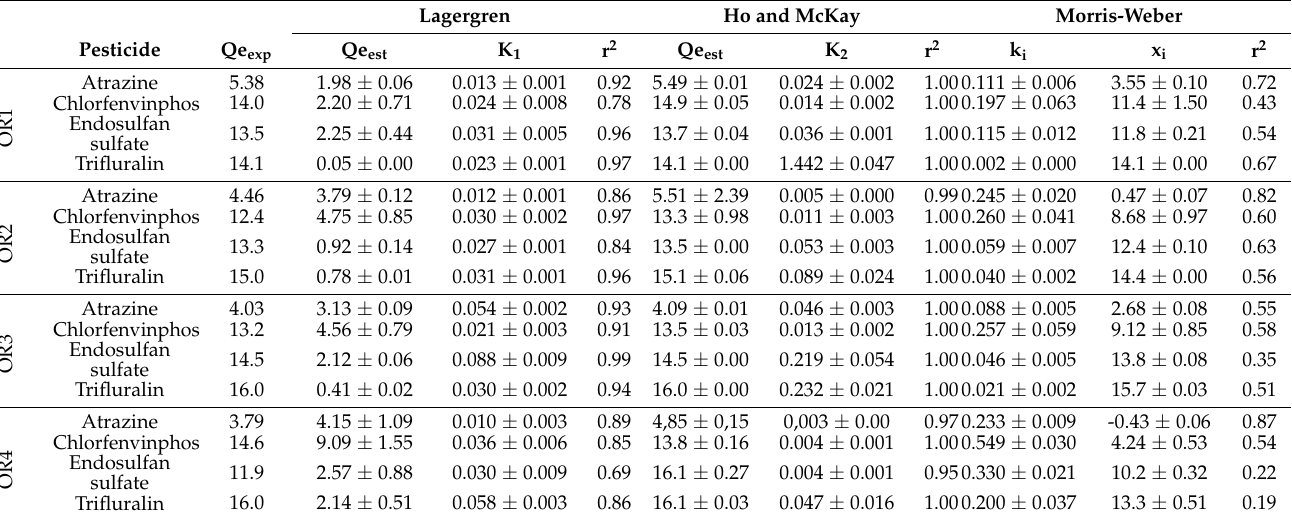
Table 2. Experimental and estimated values of the studied kinetic models.